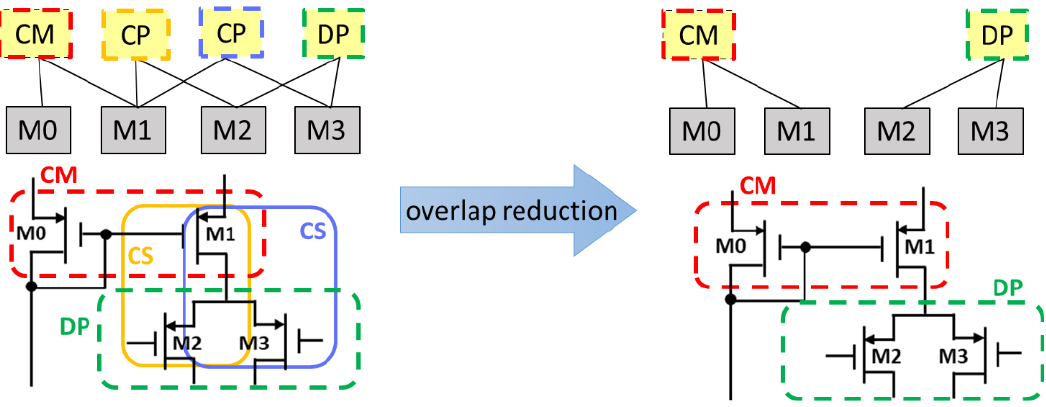
Figure 11. Example of bond strength selection for overlapping problems.